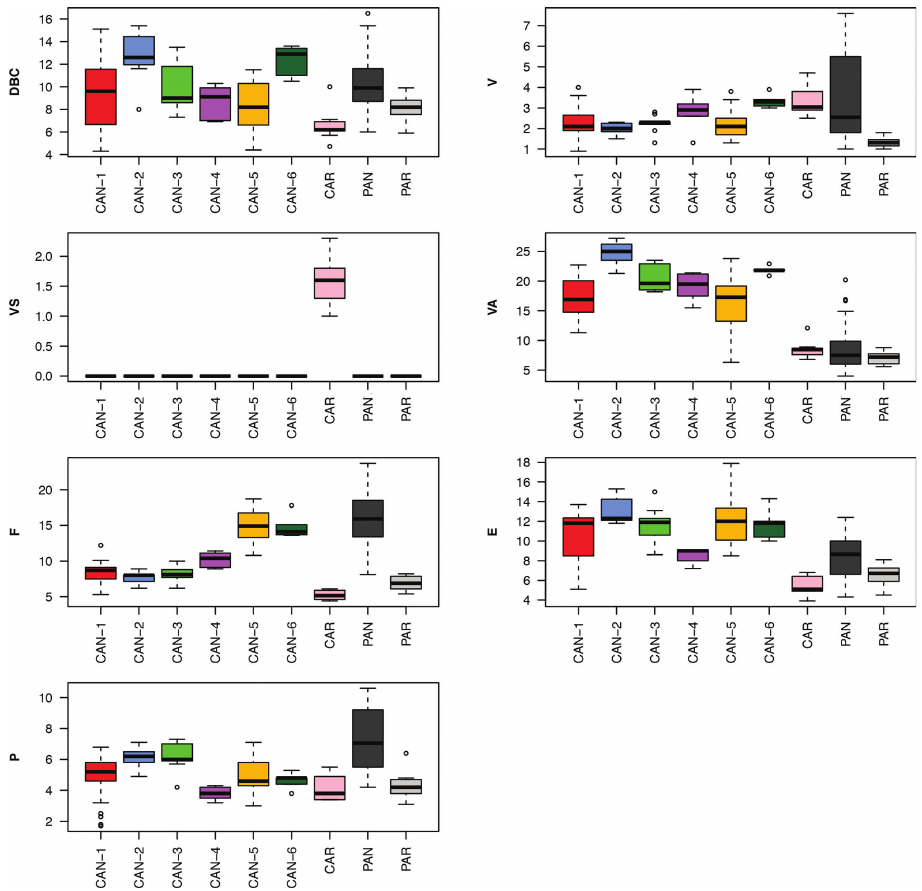
Figure 66. Box plots for genital characters of the ten Monacha species or molecular lineages investigated. The lower and upper limits of the rectangular boxes indicate the 25 th to 75 th percentile range, and the horizontal line within the boxes is the median (50 th